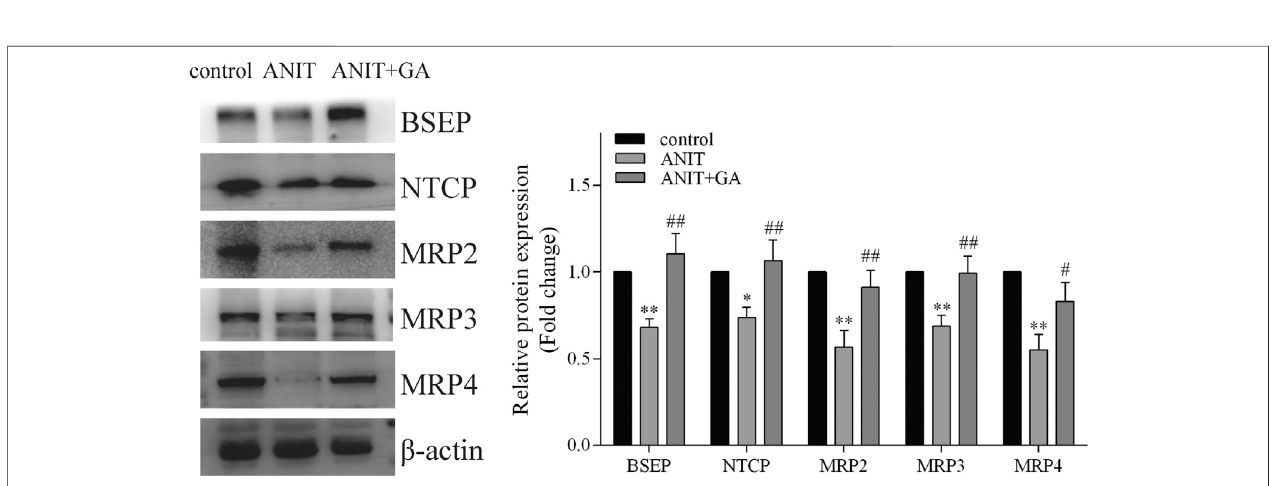
FIGURE 4 | GA alters protein expression of BSEP, NTCP, MRP2, MRP3, and MRP4 in ANIT treatment ( n (cid:1) 6).